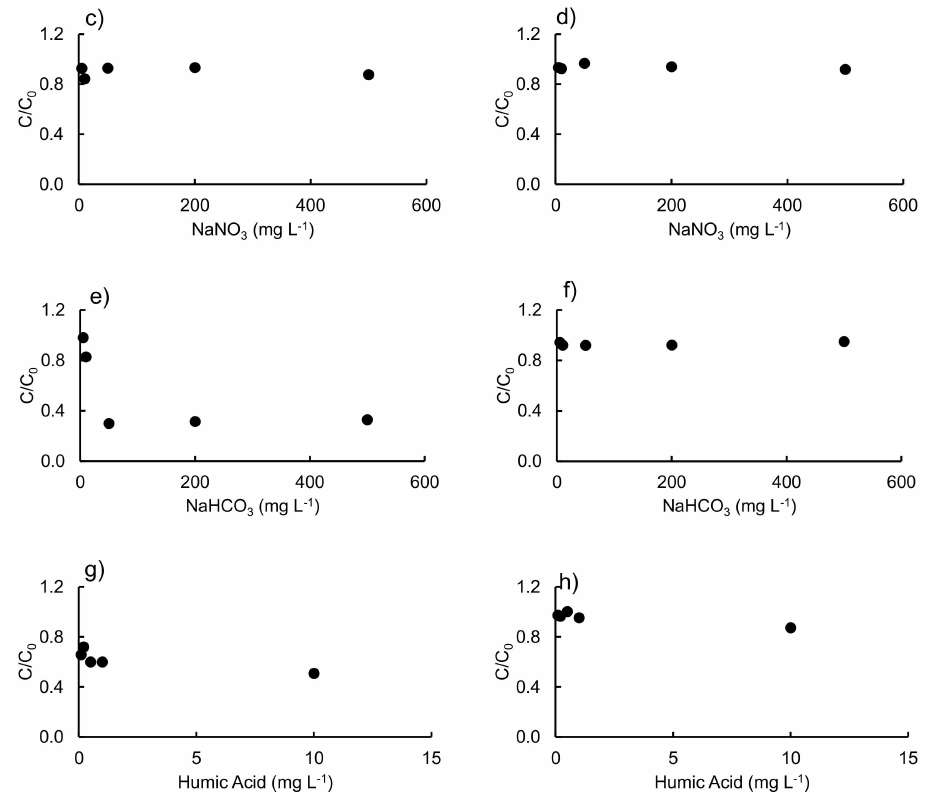
Figure 6. Enrofloxacin (ENR) degradation under simulated sunlight and in the dark, in the presence of different salts or humic acids. ( a ) Presence of NaCl under simulated sunlight; ( b ) Presence of NaCl in the dark; ( c ) Presence of NaNO 3 under simulated sunlight; ( d ) Presence of NaNO 3 in the dark; ( e ) Presence of NaHCO3 under simulated sunlight; ( f ) Presence of NaHCO 3 in the dark; ( g ) Presence of humic acids under simulated sunlight; ( h ) Presence of humic acid in the dark. Coefficients of variation were always lower than 10%.